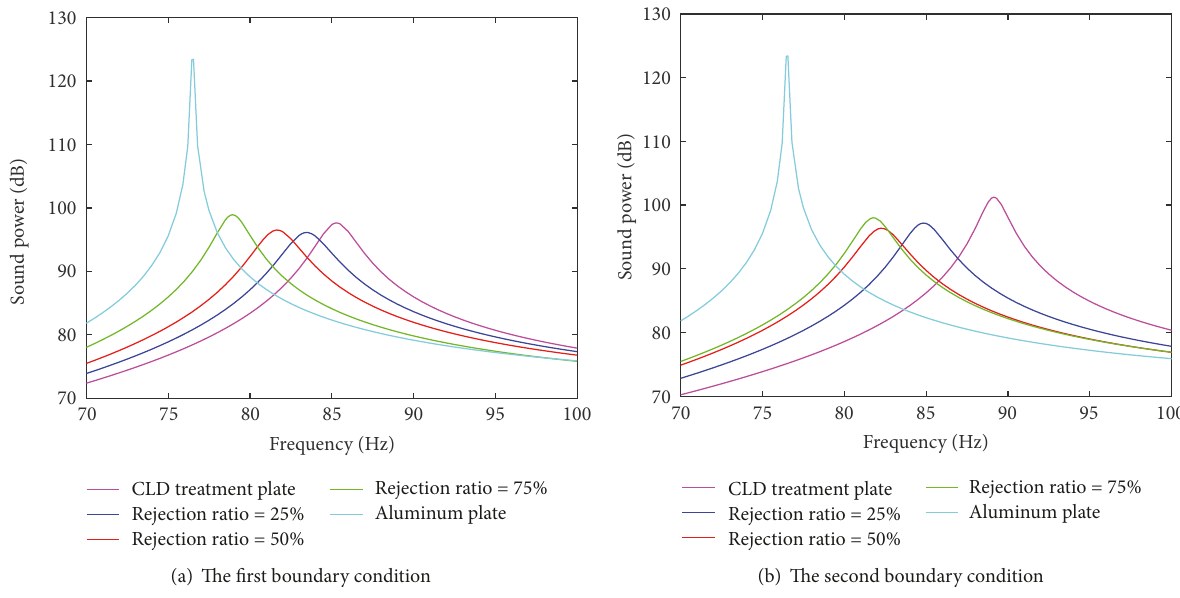
Figure 14: Frequency responses of sound power under various rejection ratios obtained using